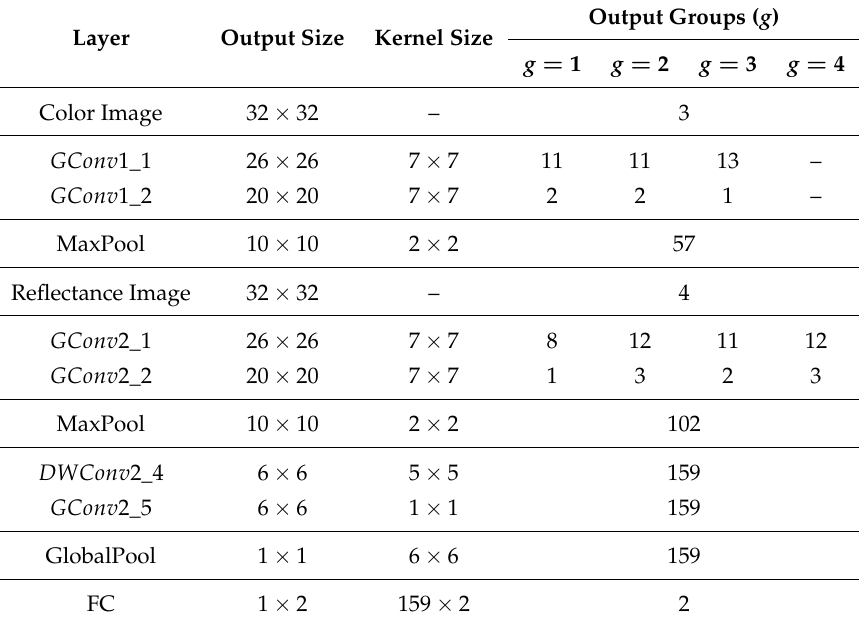
Table 1. Detail parameters in the lightweight fusion network. Key: Output groups are the number of group convolutions in each layer and each group; FC denotes fully convolutional